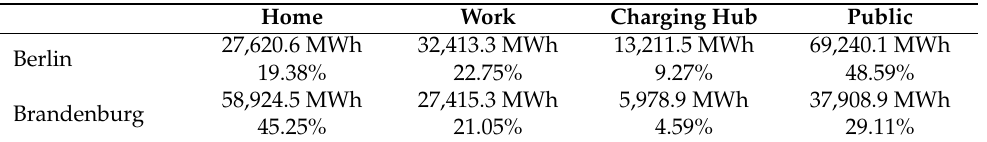
Table 4. Energy charged by the entire electric vehicle fleet in the four use cases considered in Berlin and Brandenburg.